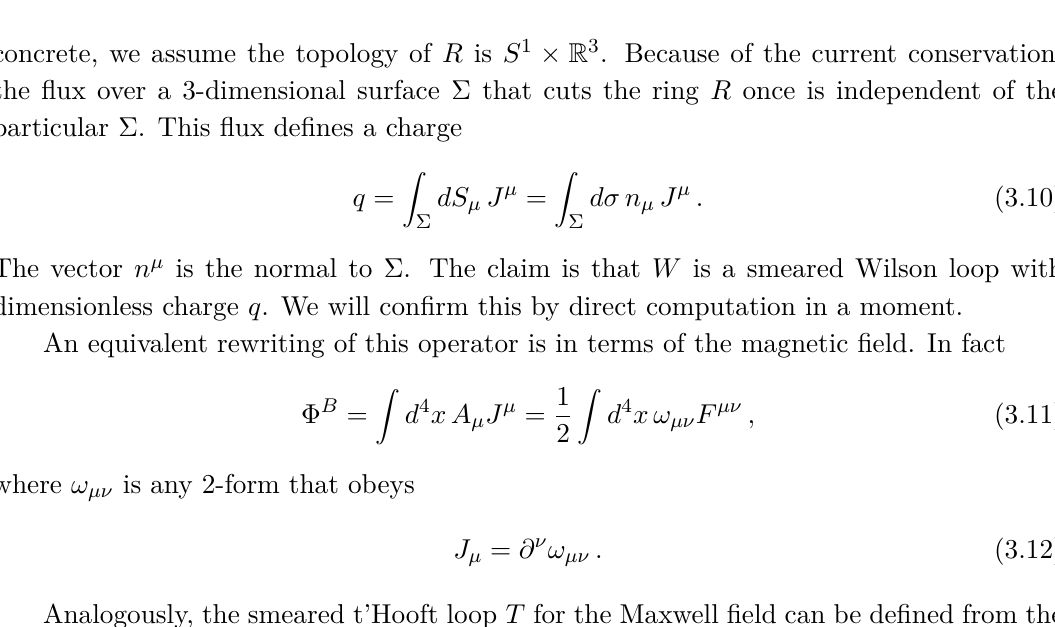
Figure 2 . The ring-like regions R and ˜ R are the support of the currents J ( x ) and ˜ J ( x )